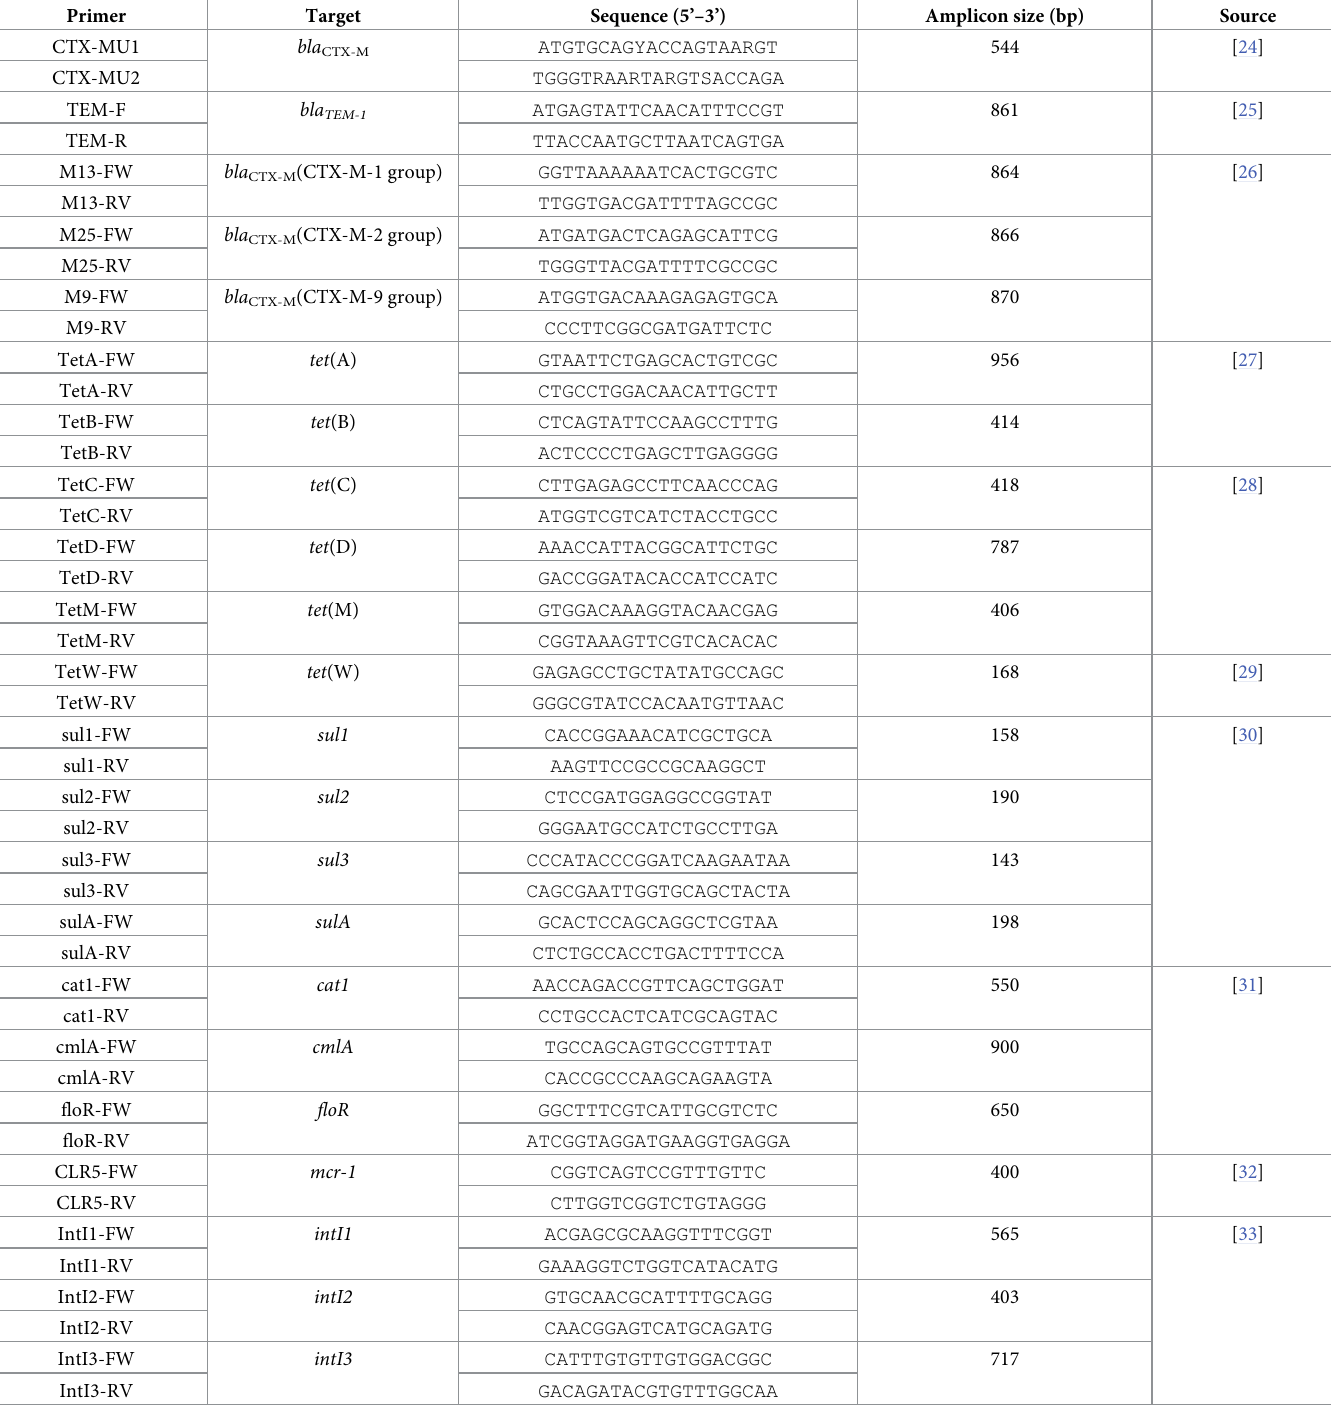
Table 1. PCR primers and